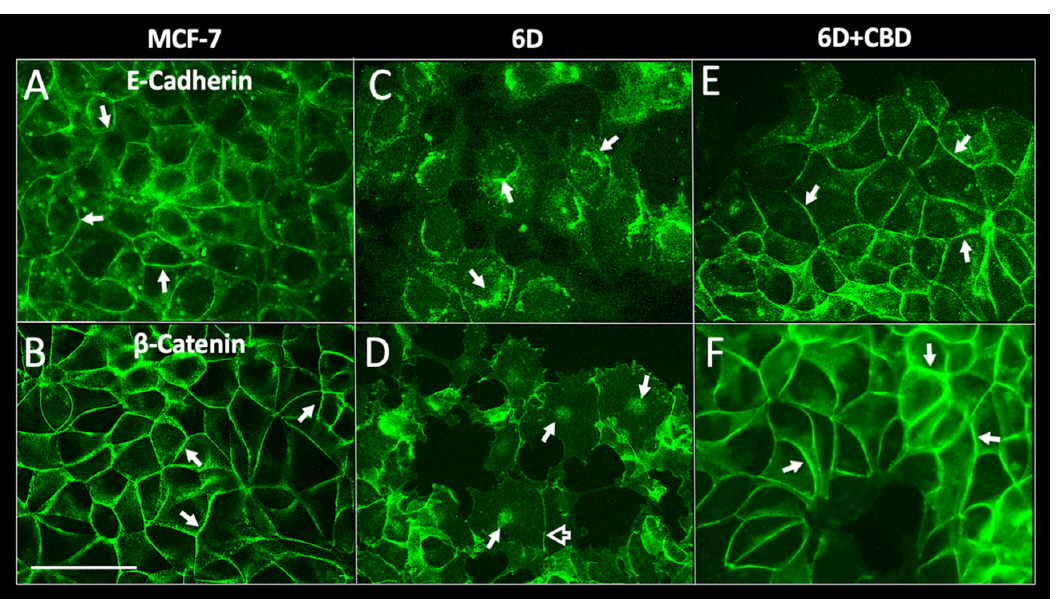
Figure 3. Immunolocalization of adherens junction proteins E-cadherin and β-catenin. MCF-7 and 6D cells treated or not treated with 10 µM CBD were cultured for 48 h, fixed, and stained with specific antibodies to E-cadherin and β-catenin. ( A ) E-cadherin is localized in the periphery of MCF-7 cells. Adherens junctions are indicated by arrows. ( B ) β-catenin in MCF-7 cells also is localized at the intercellular junctions (arrows). ( C ) In 6D cells stained to visualize E-cadherin the protein is in the cytoplasm and around the nuclei (arrows). ( D ) β-catenin in the dispersed 6D cells is localized in the nuclei (arrows) and a faint signal is still visible in the remaining junctions (empty arrow). ( E ) 6D cells treated with 10 µM CBD showed E-cadherin normal localization in the periphery of the cells making contact (arrows). ( F ) In 6D cells treated with CBD, β-catenin is localized and mostly increased in the reconstituted adherens junctions (arrows). In addition, β-catenin is no longer detected in the nuclei. Bar = 50 µm.